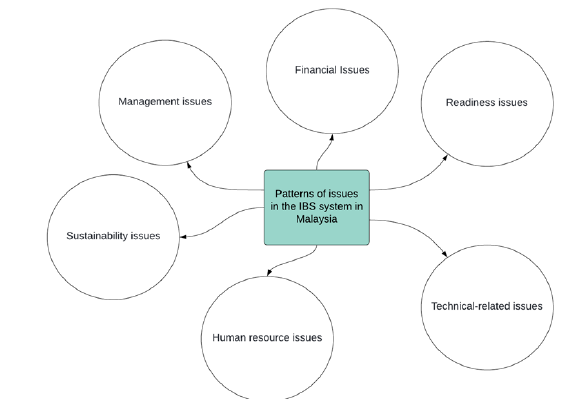
Fig. 10. Patterns of issues in the IBS construction in